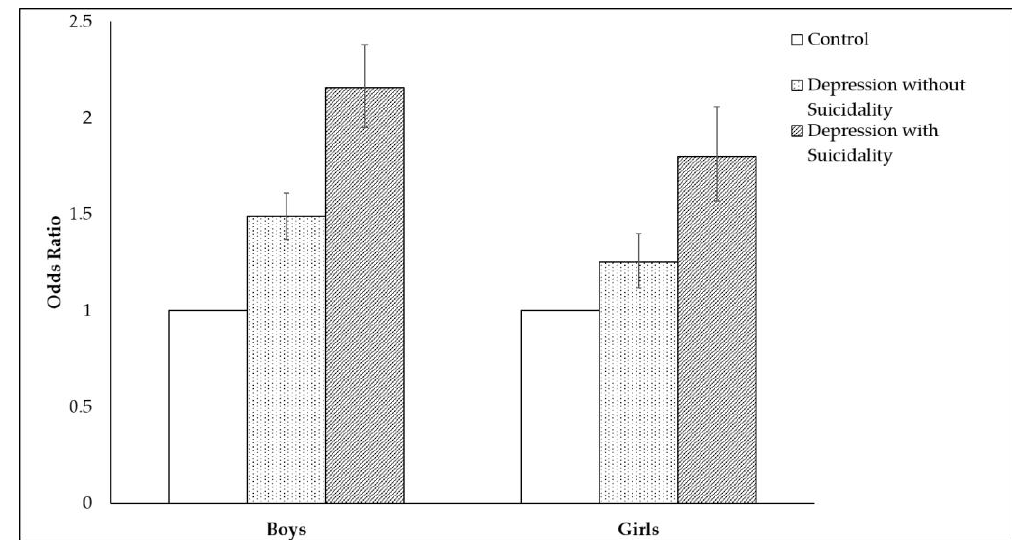
Figure 1. Odds ratios of depression without suicidality and depression with suicidality. The group without depression serves as the reference.